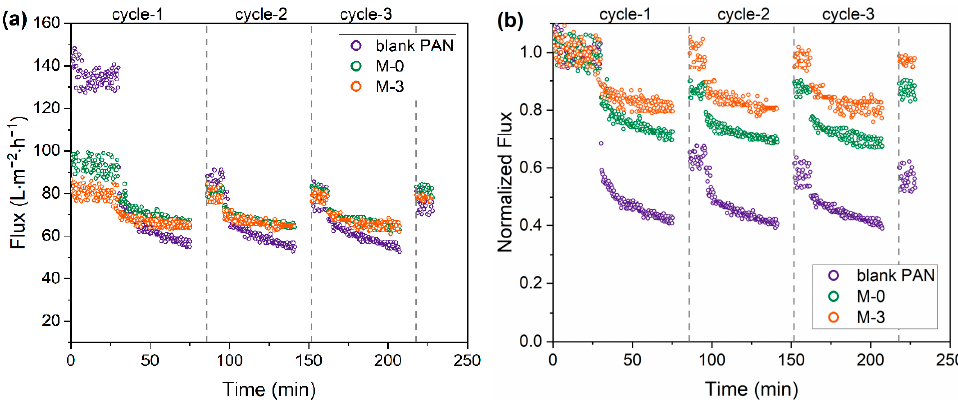
Figure 9. ( a ) Flux and ( b ) normalized flux variation of the blank PAN, M-0, and M-3 membranes. Table 2. Initial pure water flux ( J w ), flux at cycle end ( J p ), recovered flux ( J r ), relative flux decline ( RFD ), relative recovery ratio ( RFR ), and BSA rejection rate ( R ) during 3-cycle BSA filtration test for the blank PAN, M-0, and M-3 membranes.